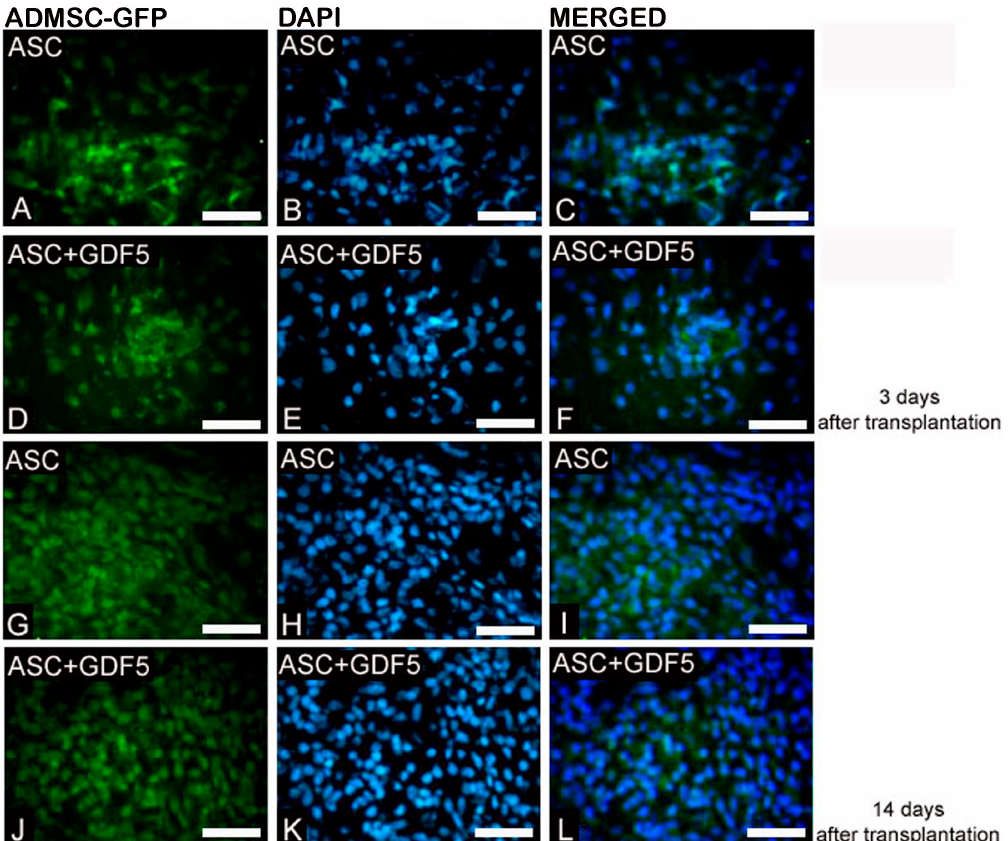
Figure 3. ADMSC-GFP Migration to TR on the 3rd and 14th days after injury: Observe the presence of ADMSC-GFP ( A , D , G , J ) in the ASC and ASC+GDF5 groups. Visible higher numbers of cells can be observed on the 14th day in both groups. DAPI: Nuclei marking ( B , E , H , K ). Merged images of ADMSC-GFP with nuclei marked with DAPI ( C,F,I,L ). Bar = 50 μ